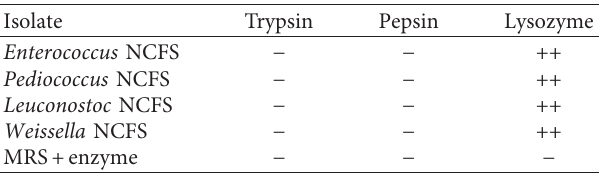
Table 7: Inhibitory activity of CFS following enzyme treatments ( S. aureus ATCC25923 was used as an indicator bacterium).